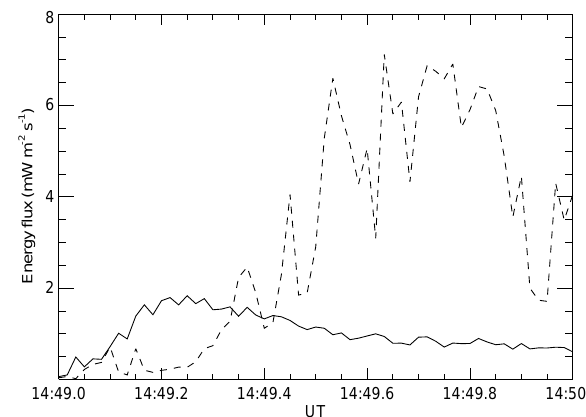
Fig. 3. Energy fluxes of auroral electrons (dashed line) and protons (solid line) measured along the DMSP F15 satellite orbit crossing a detached proton arc and the electron oval on 26 November 2000 at